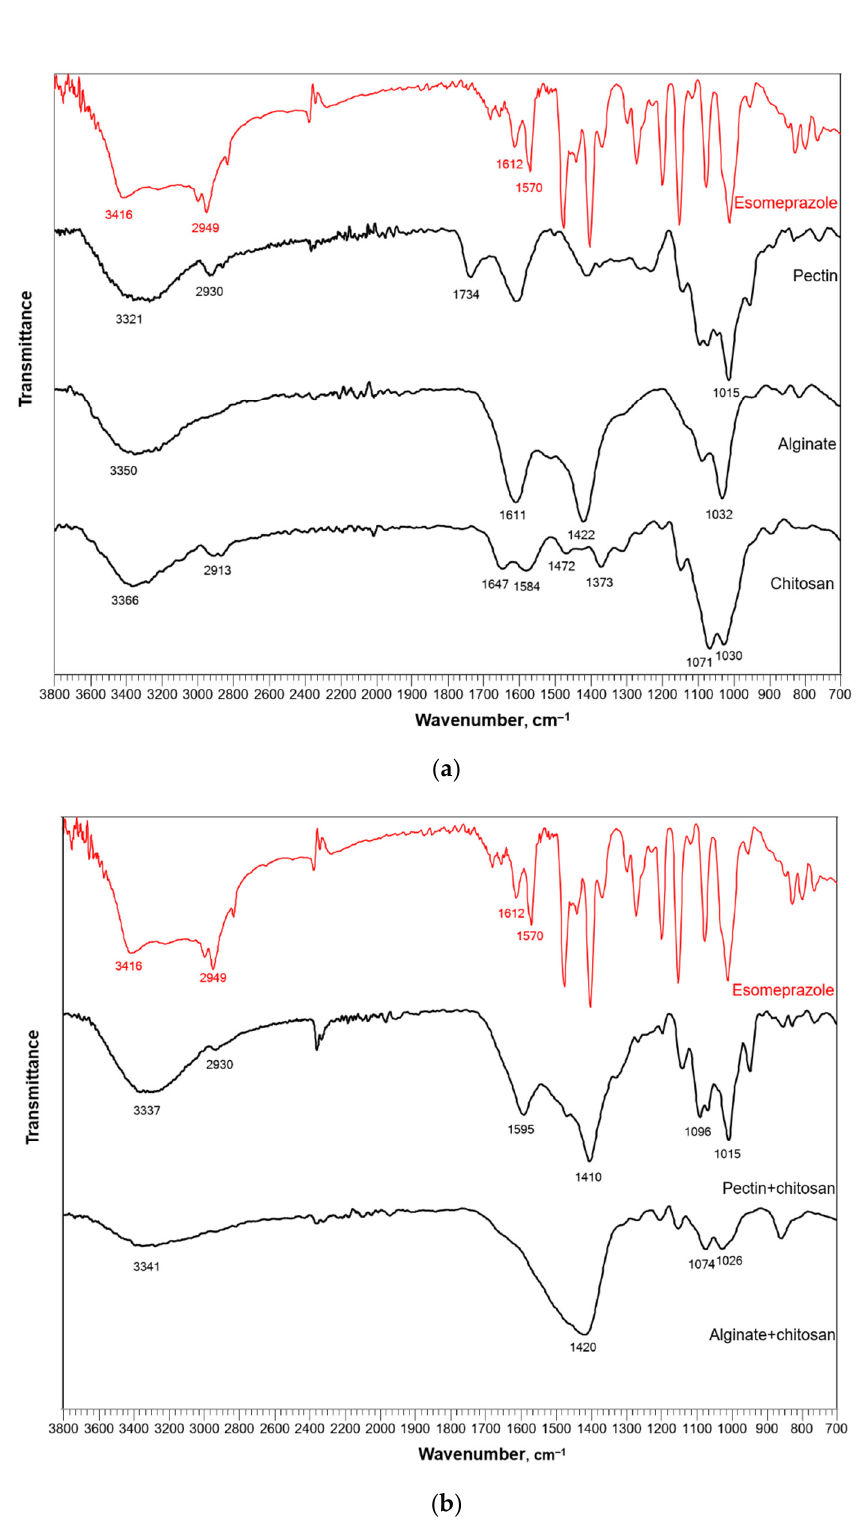
Figure 4. ( a ) FTIR spectra of pure esomeprazole and pectin, alginate, and chitosan aerogels impreg- nated with esomeprazole, ( b ) FTIR spectra of pure esomeprazole and pectin and alginate aerogels coated with chitosan impregnated with esomeprazole.